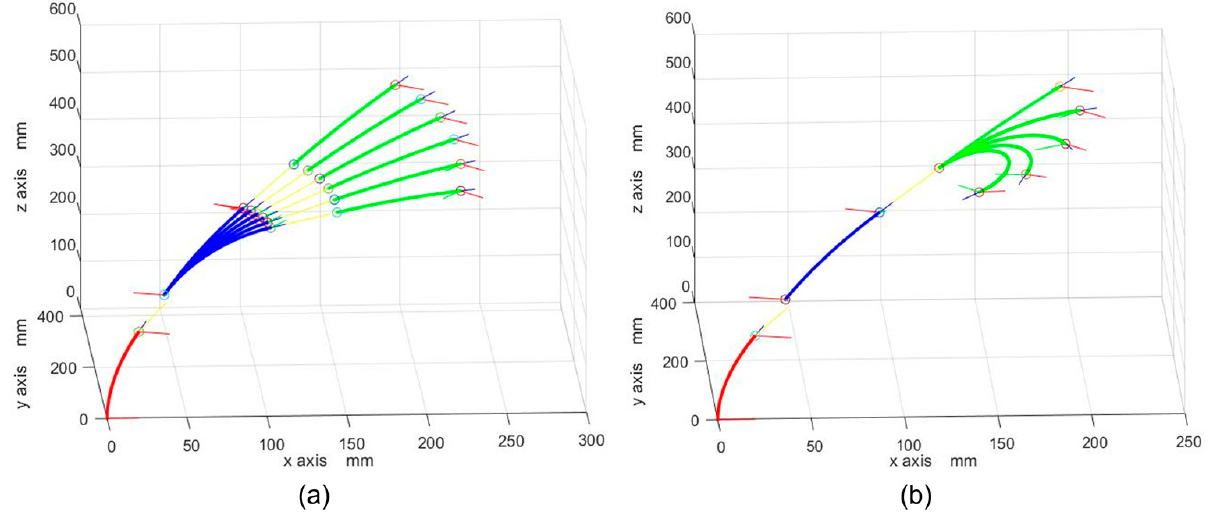
Figure 13. Kinematic simulation of the flexible manipulator: ( a ) change in the arc curvature κ of the